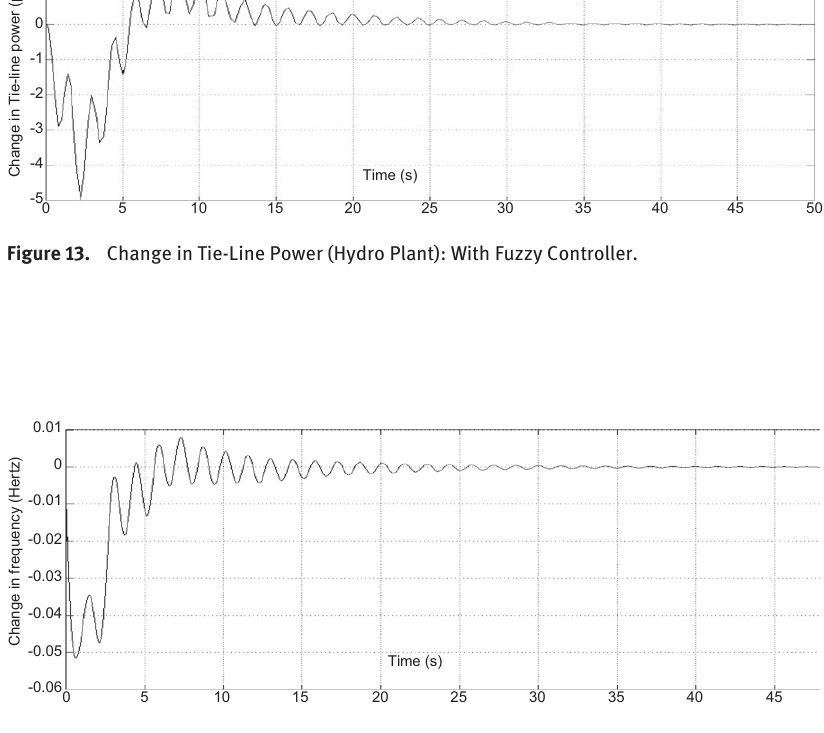
Figure 14. Change in Frequency (Thermal Plant): With ANN Controller.